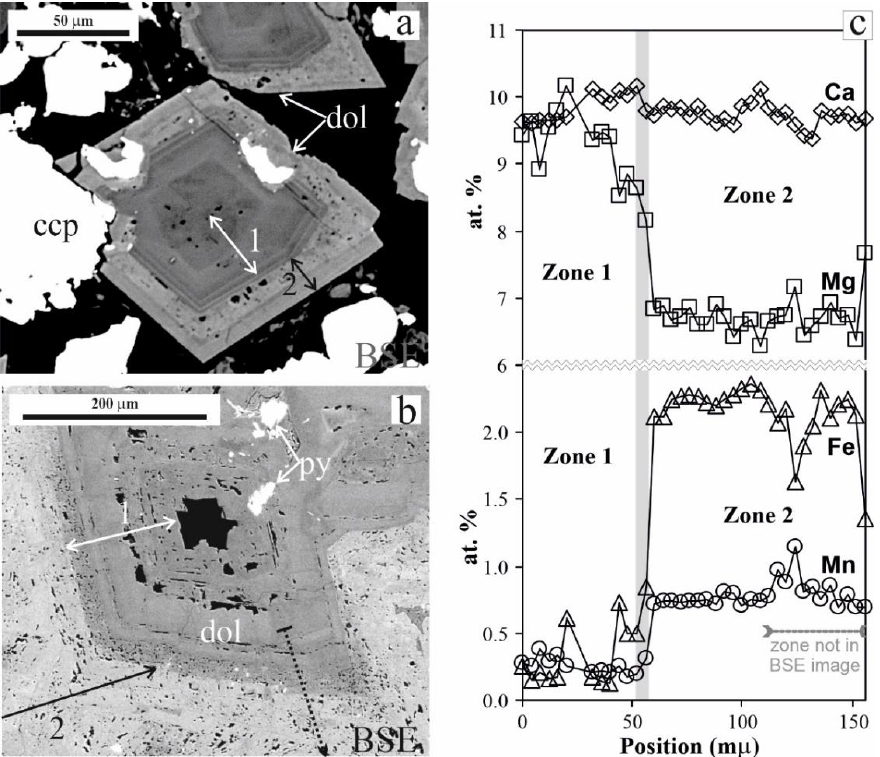
Figure 6. Back-scattered electron (BSE) images ( a , b ) of zoned dolomite/ankerite from the Palai-Islica orebody (SE Spain) in which two main zones 1 (earlier and darker in BSE), and 2 (later and brighter in BSE) are distinguished. In ( c ), a profile through the crystal of picture b (indicated by a dotted line, which end is out of the picture) is shown, being represented Mg, Ca, Fe, and Mn atomic % contents.